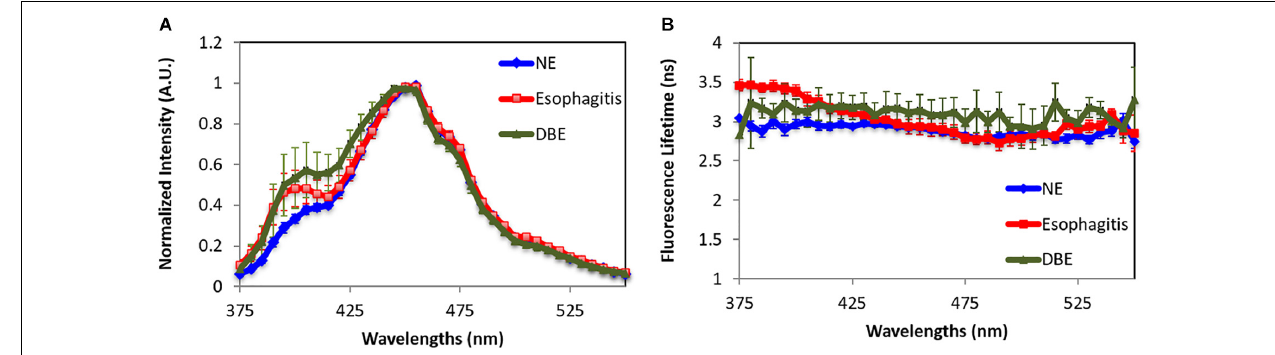
FIGURE 3 | Fluorescence characteristics of normal esophagus (NE), dysplasia Barrett’s esophagus (DBE), and esophagitis tissue. (A) Spectra. (B) Lifetime. Data are presented as mean ± standard